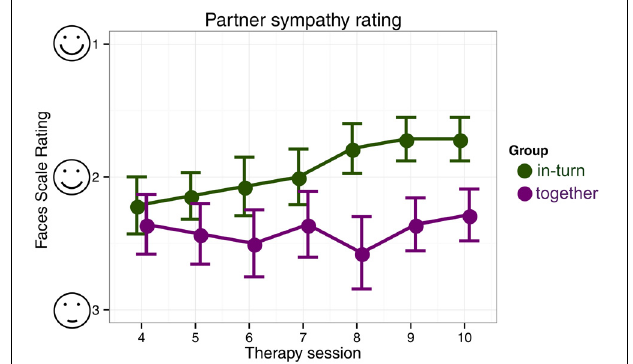
FIGURE 5 | Patient’s likeability rating of their therapy partner. We indicate mean and standard errors of the ratings for each group for clarity of presentation, although our statistical analysis was